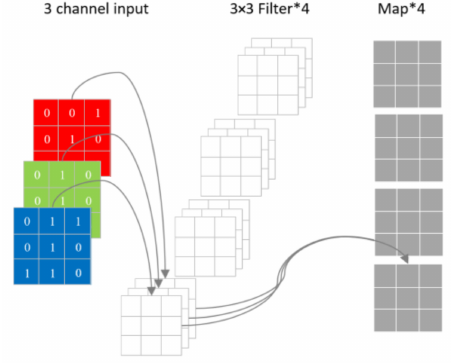
Figure 7. Traditional CNN convolution